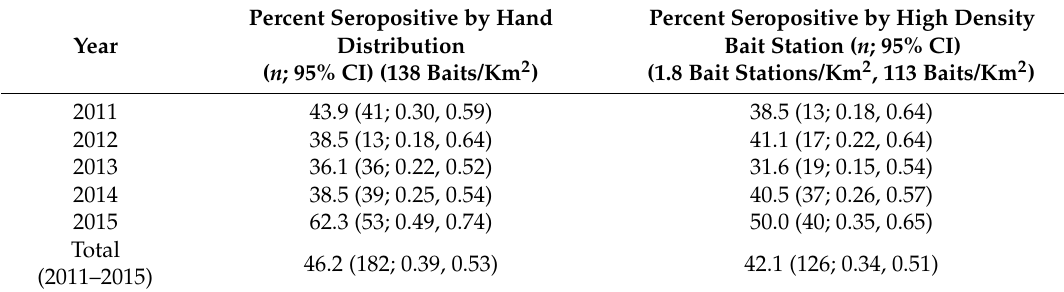
Table 1. Post-ORV raccoon serology rates on Cape Cod,